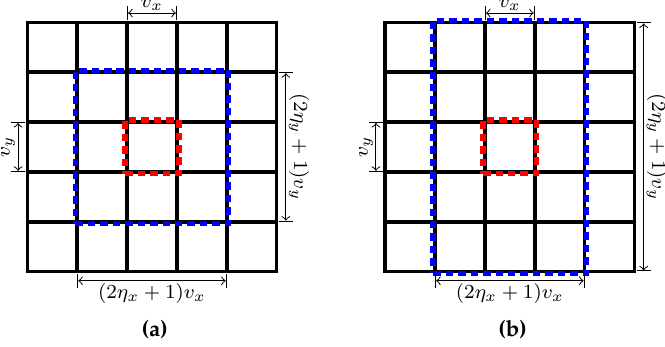
Figure 4. Illustration of anchor region and overlap region with two different settings for η x and η y : ( a ) η x = η y = 1, ( b ) η x = 1, η y = 2. In this example of both ( a ) and ( b ), n x = n y = 5 and the 25 anchor regions are marked with black rectangles. The region within the blue rectangle is the overlap region I k of supervoxel k = 13 whose anchor region is highlighted by a red